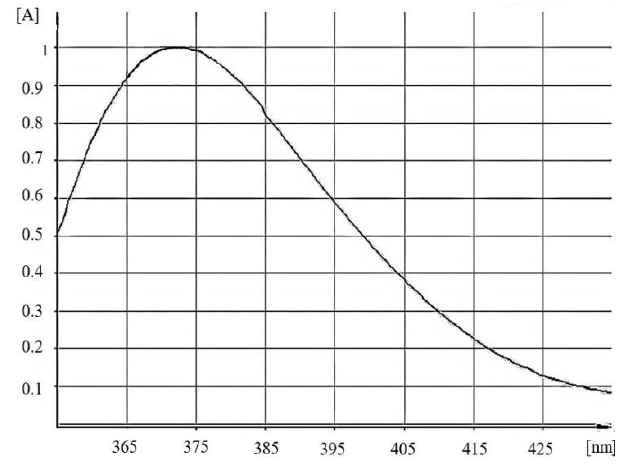
Fig. 2. Adsorption spectrum of samples with diosmin and